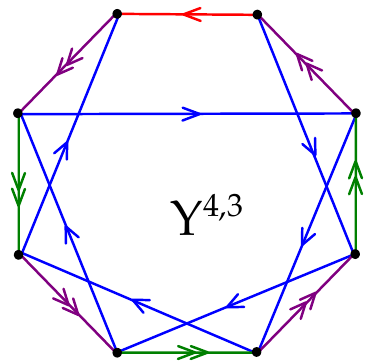
Figure 3 . The Y 4 ; 3 quiver diagram. The quiver diagram for Y 4 ; 3 . The (cid:12)elds have been colour- coded as follows: the Y (cid:12)elds are shown in blue, Z (cid:12)elds in red, U i (cid:12)elds are purple and V i (cid:12)elds